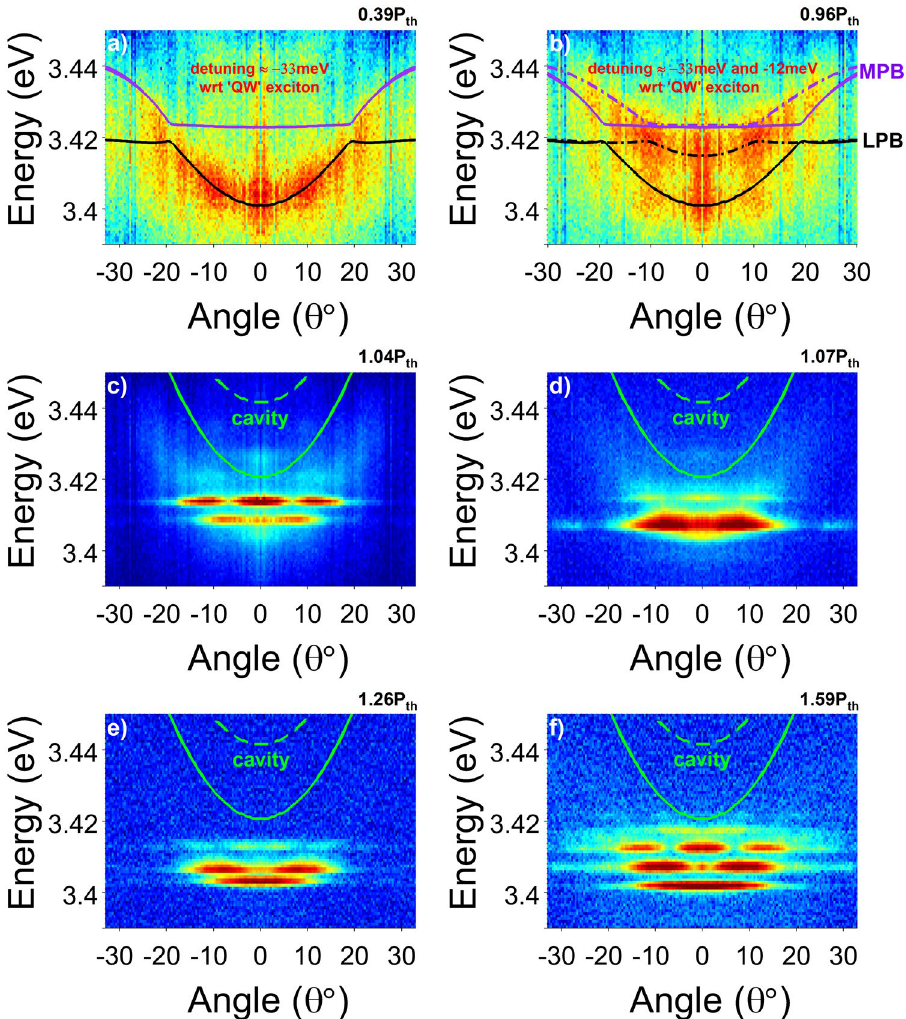
Figure 3. Angle-dependent room-temperature PL at various excitation powers around threshold. ( a ) 0.39 · P th , ( b ) 0.96 · P th , ( c ) 1.04 · P th , ( d ) 1.07 · P th , ( e ) 1.26 · P th , and ( f ) 1.59 · P th . The polariton condensation above threshold is associated to a distinct multimode k-space pattern, far below the theoretical cavity mode dispersions corresponding to LPB 1 (solid line) and LPB 2 (dashed line). Data obtained from membrane